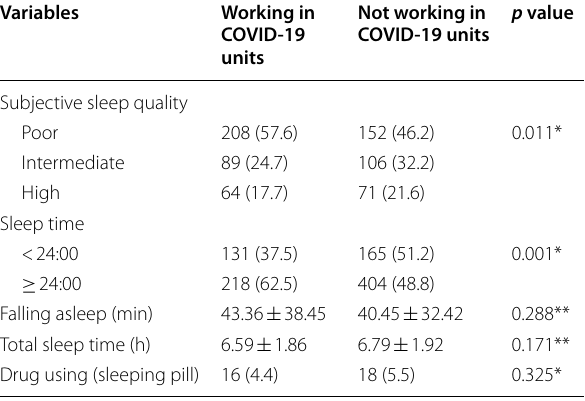
Table 1 Demographic information of the participants